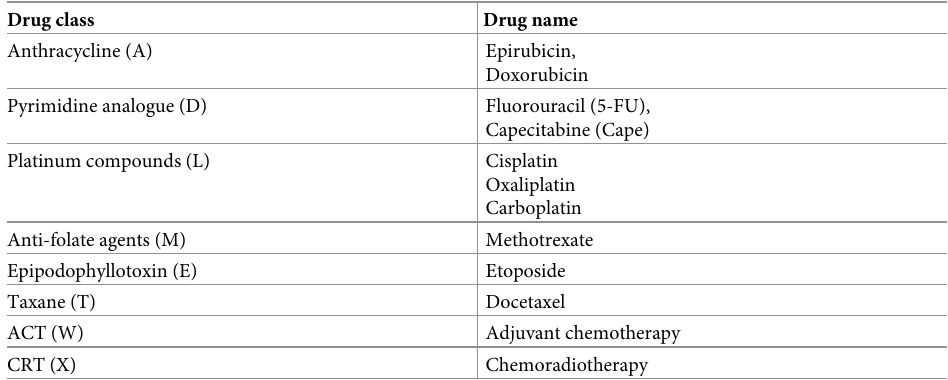
Table 1. Drug classes along with individual drug